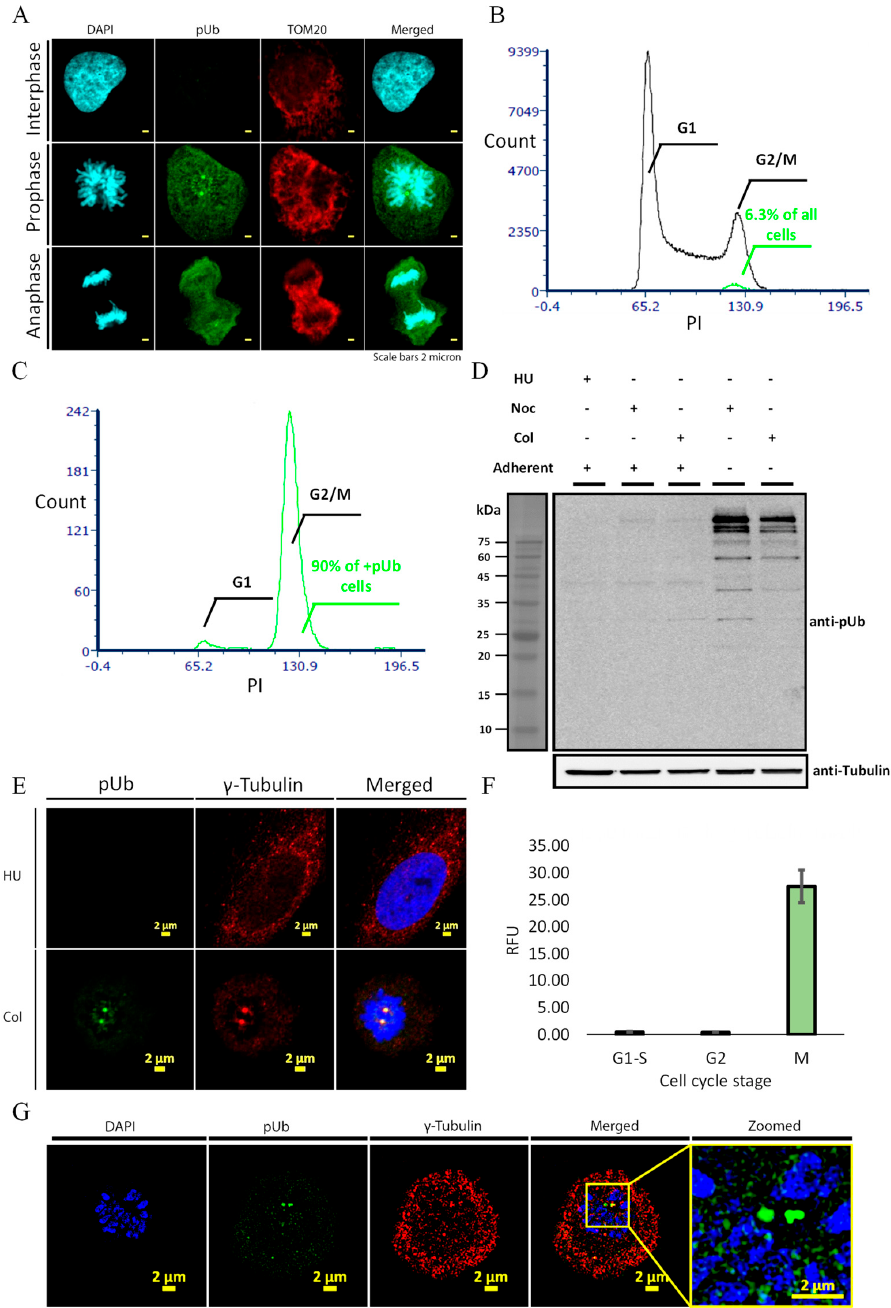
Figure 1. Antibody for pUb recognizes and binds mitosis-related phosphorylation events in U2OS cells. ( A ) Confocal imaging of interphase and mitotic U2OS cells with pUb (green) and TOM20 (red) antibodies and DAPI (cyan); ( B ) cell cycle distribution of unsynchronized U2OS cell stained with propidium iodide (PI) and AF488 conjugated pUb antibody. Green overlay is pUb positive cells; ( C ) histogram of PI intensity under pUb positive gate shows that almost all pUb positive cells are in G2/M stage; ( D ) Western blot analysis of U2OS cells in different cell cycle stages with pUb antibody. Representative result of three independent experiments; ( E ) confocal imaging of interphase and mitotic U2OS cells with pUb (green) and γ —Tubulin (red) antibodies and DAPI (blue); ( F ) quantification of pUb signal fluorescence intensity from cells in D using γ —Tubulin mask; ( G ) SIM of interphase and mitotic U2OS cells with pUb (green) and γ —Tubulin (red) antibodies and DAPI (blue). Scale bar for images are 2 micron. Flow cytometry histograms are representative results from three independent experiments (>10,000 cells each).